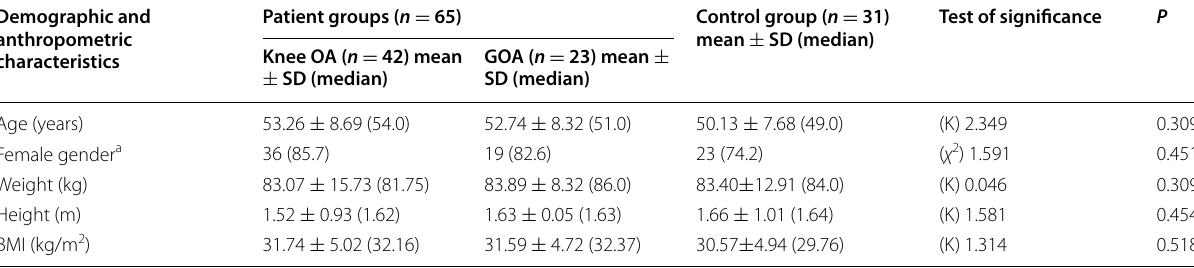
Table 1 Demographic and anthropometric characteristics in patient groups and control group